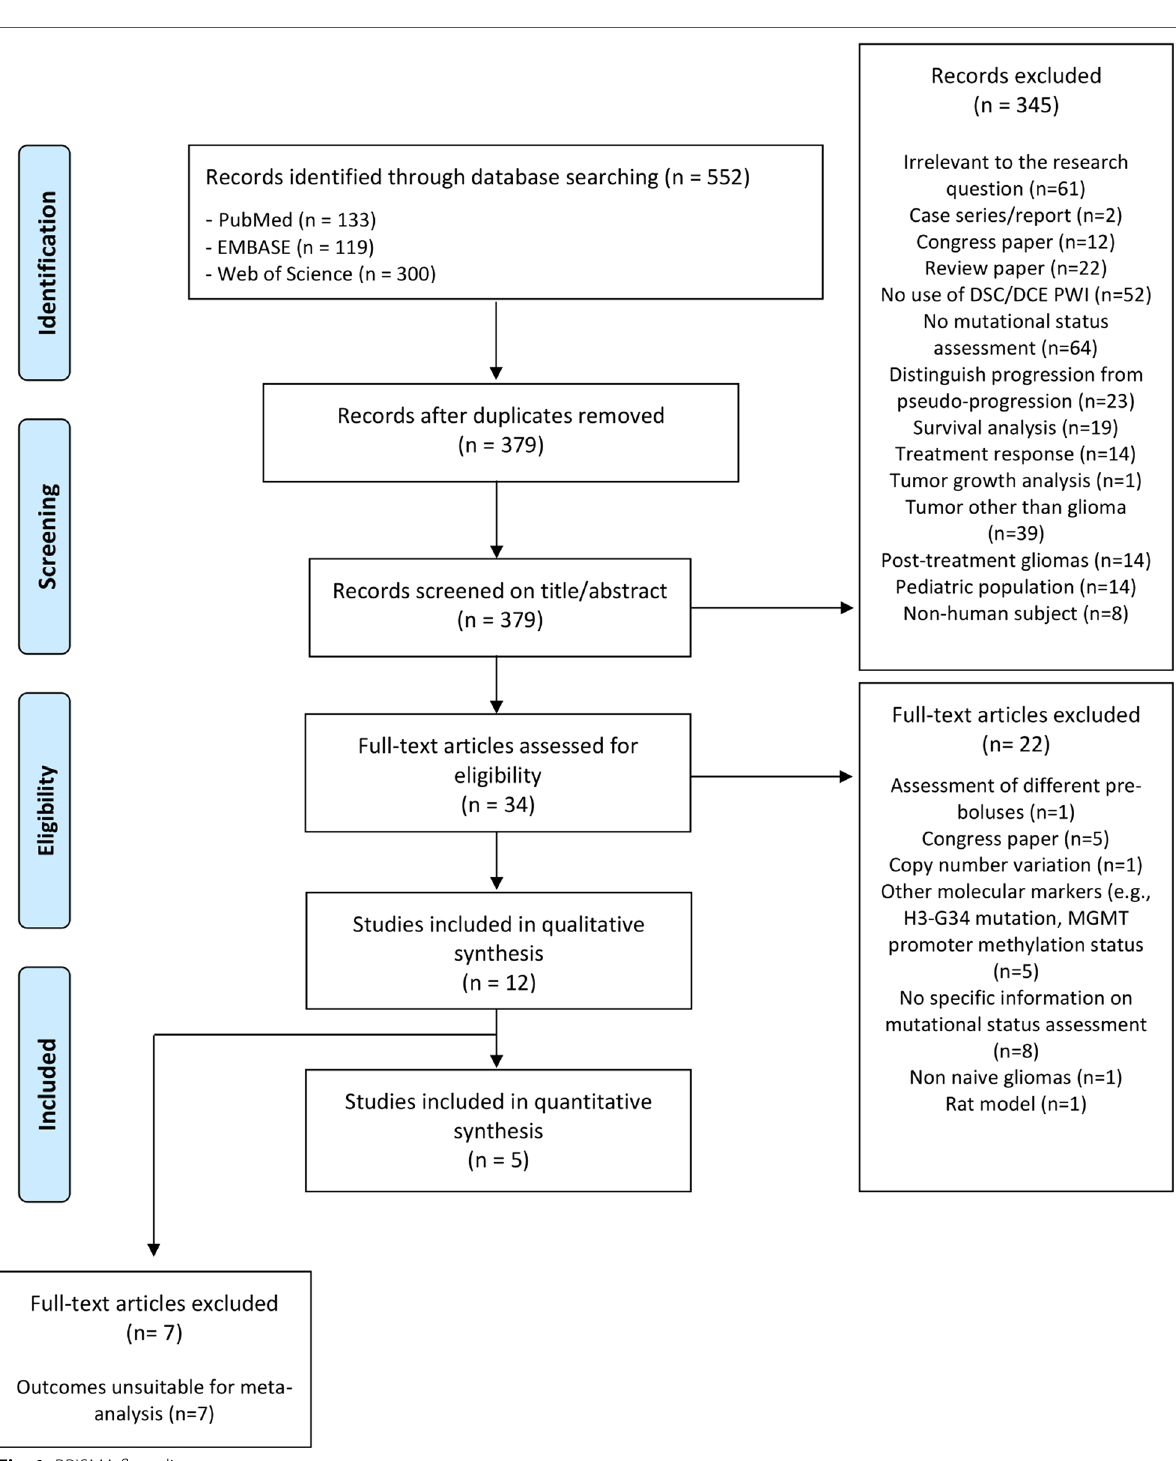
Fig. 1 PRISMA flow